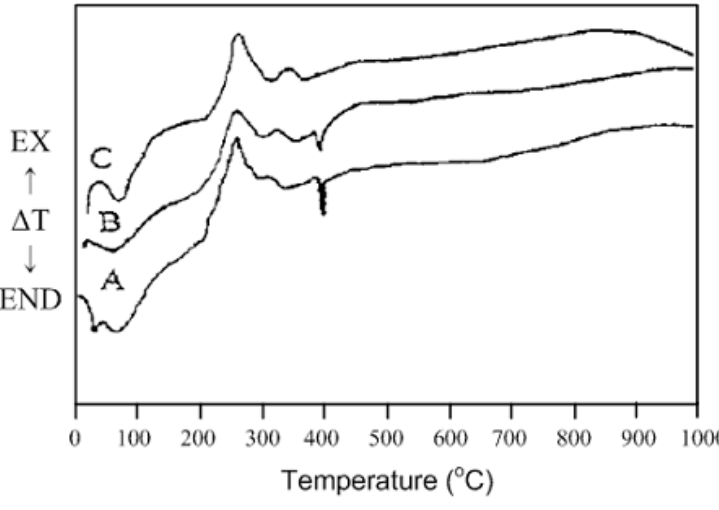
Figure 3. The DTA profiles of SnO